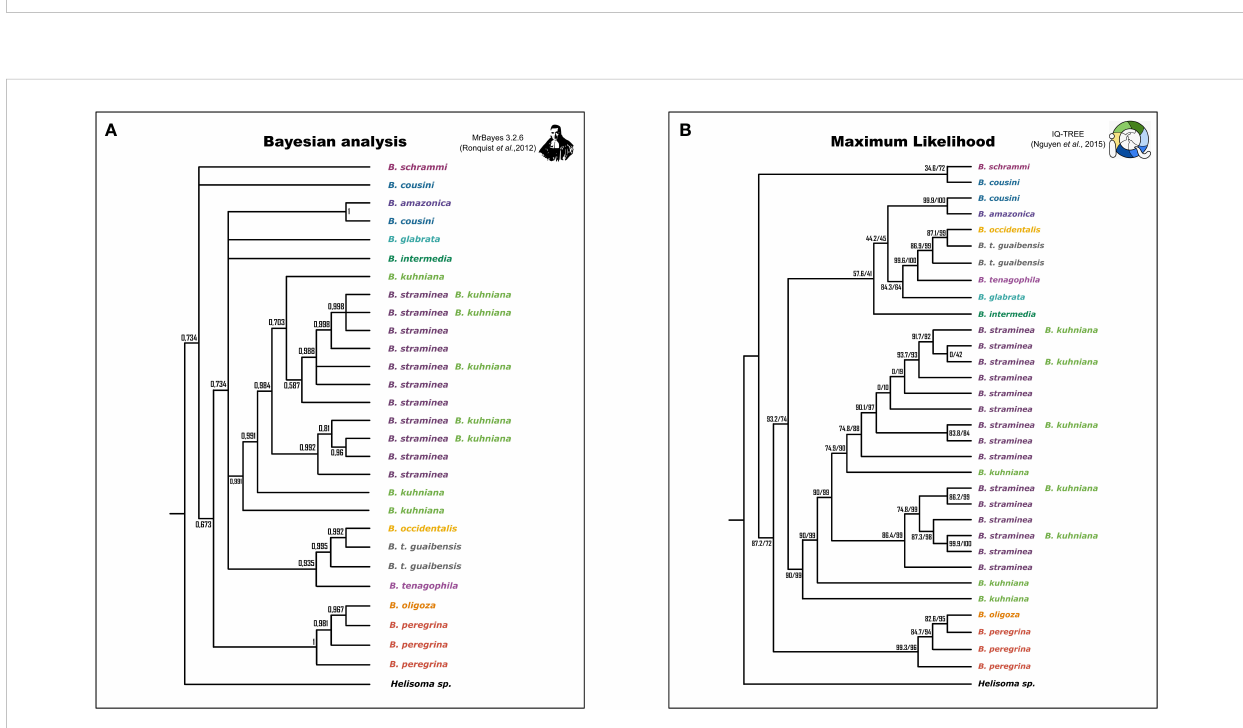
FIGURE 1 Map of Latin America showing the location of the specimens of the genus Biomphalaria used in this study. Each point represents the geographic location of a specimen, and the colors represent the different species used in the current study.